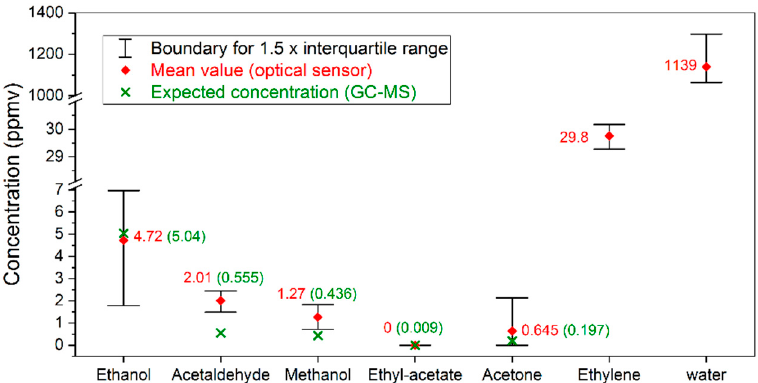
Figure 6. Comparison of the obtained concentration values using the optical method (red) and the TD-GC-MS method (green).